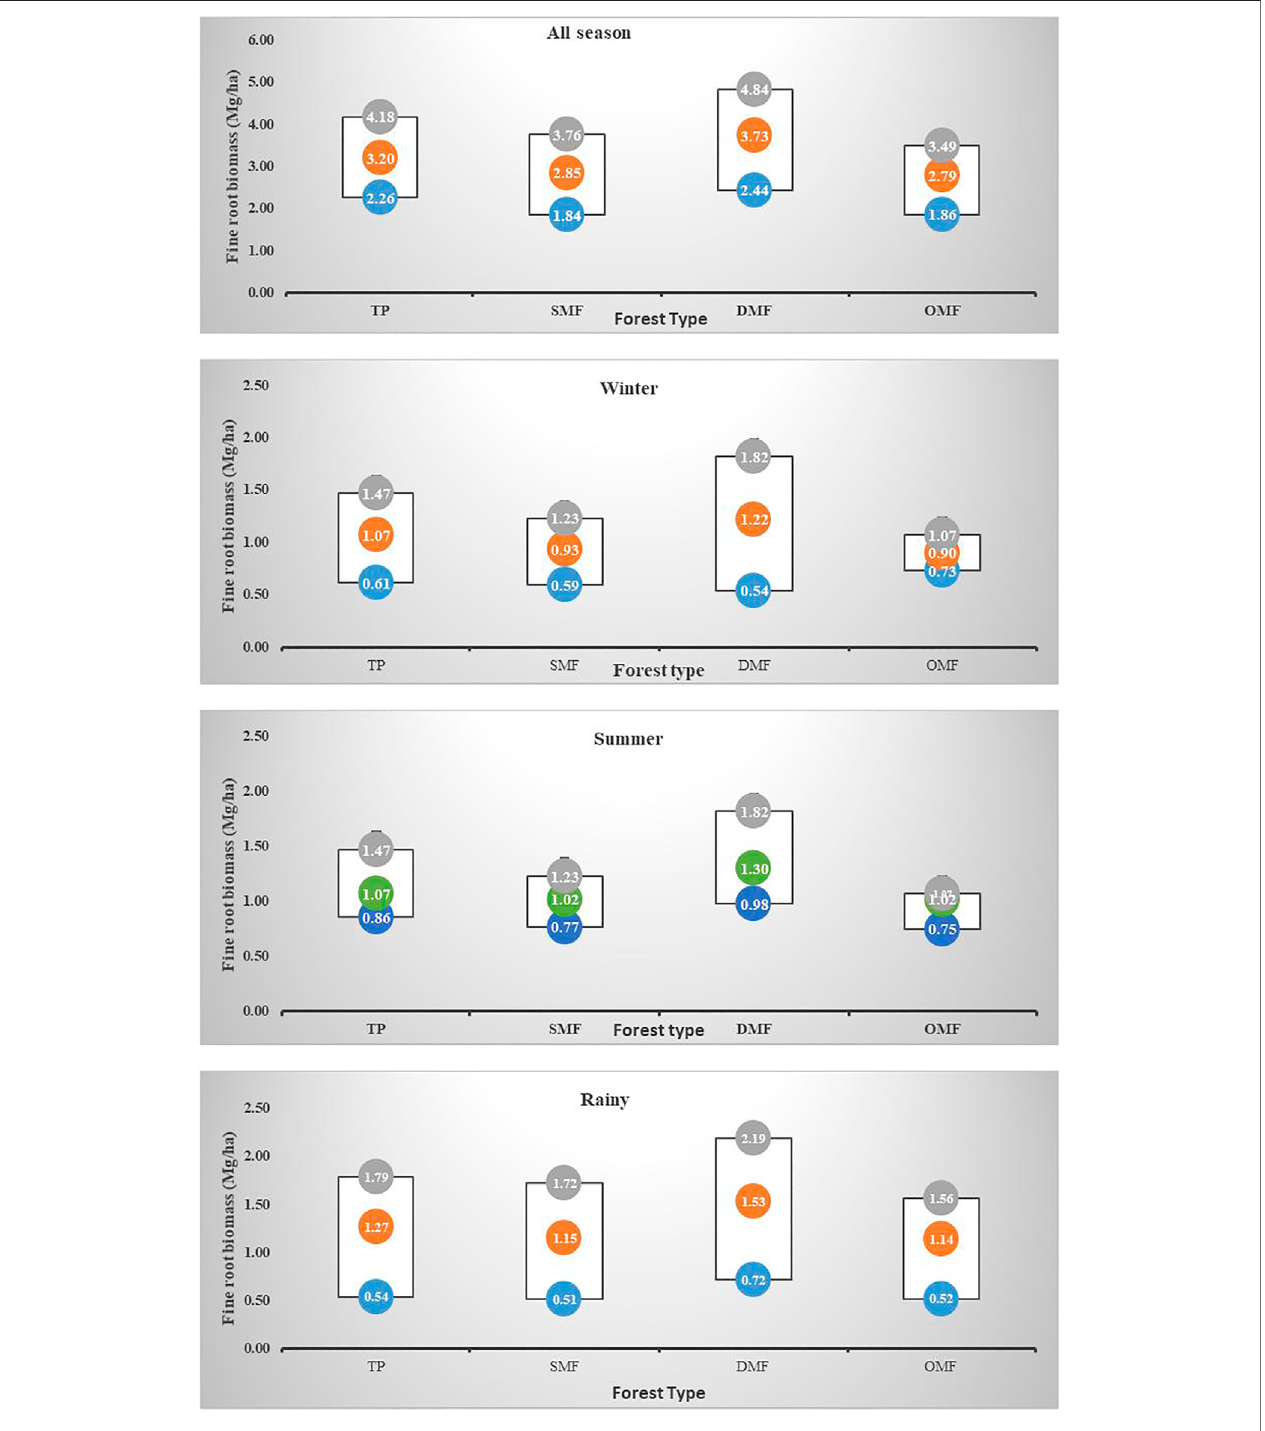
FIGURE 8 | Estimates of season wise fi ne root biomass (Mg/ha) for TP, SMF, DMF and OMF forest types during 2016 – 2018 with 95% C.I.